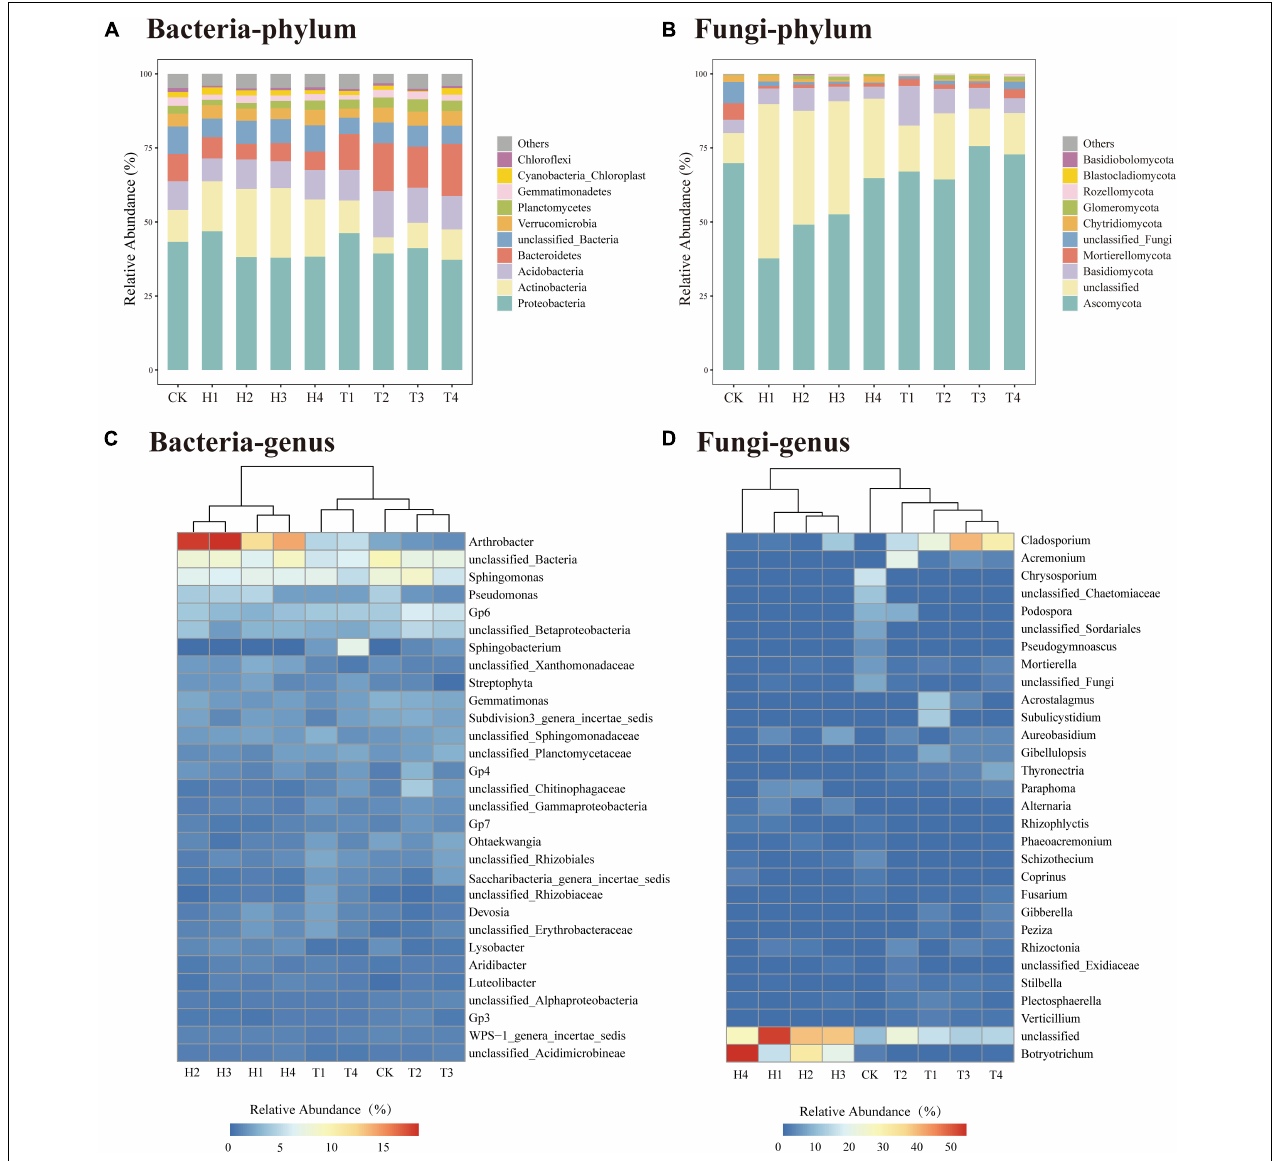
FIGURE 3 | The dynamics of the rhizosphere microbial community composition on phylum and genus levels during the continuous monoculture time series. (A) Bacterial community on phylum level. (B) Fungal community on phylum level. (C) Bacterial community on genus level. (D) Fungal community on genus